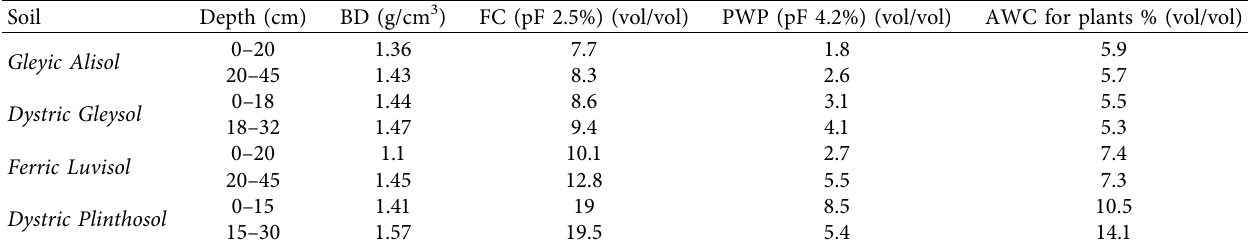
Table 3: Average values of bulk density (BD), field capacity (FC), permanent wilting point (PWP), and available water capacity (AWC) for plants. Ferric Luvisol